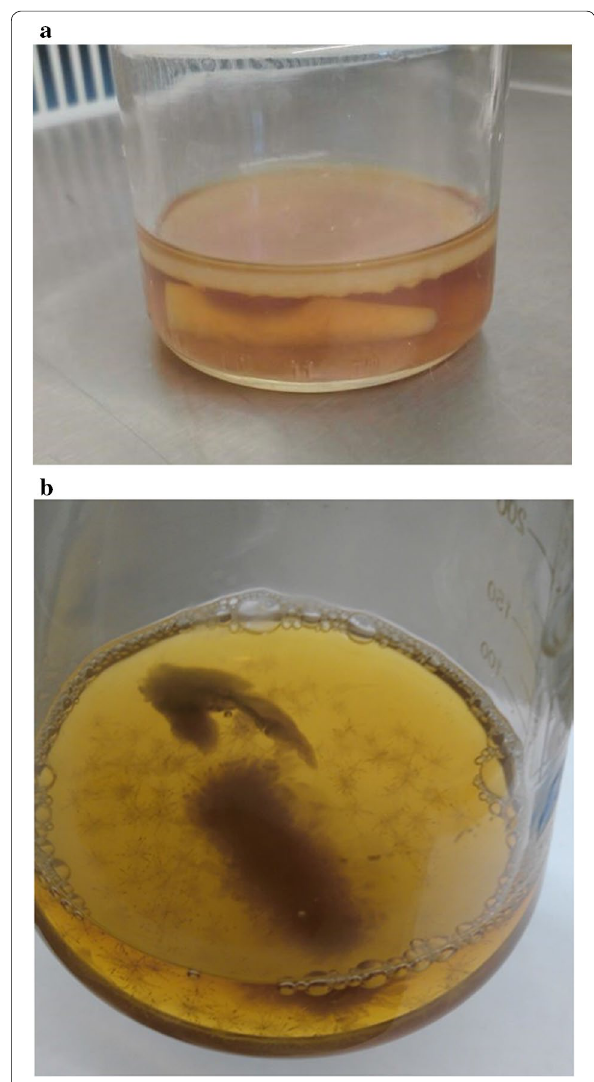
Fig. 4 Immobilized cells producing bacterial cellulose (HS medium): a static conditions of cultivation, b dynamic conditions of